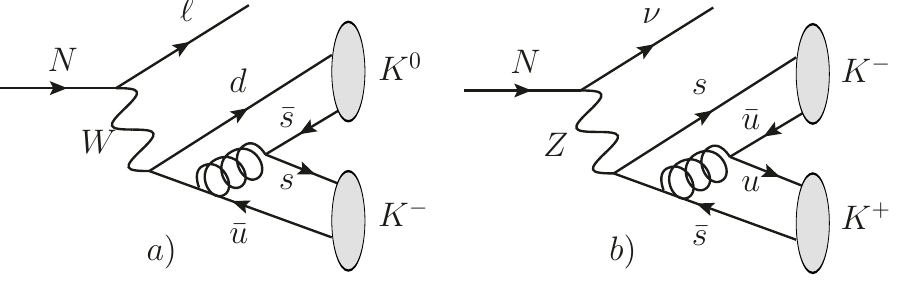
Figure 17 . HNL decays into 2 kaons through charged a) and neutral b)